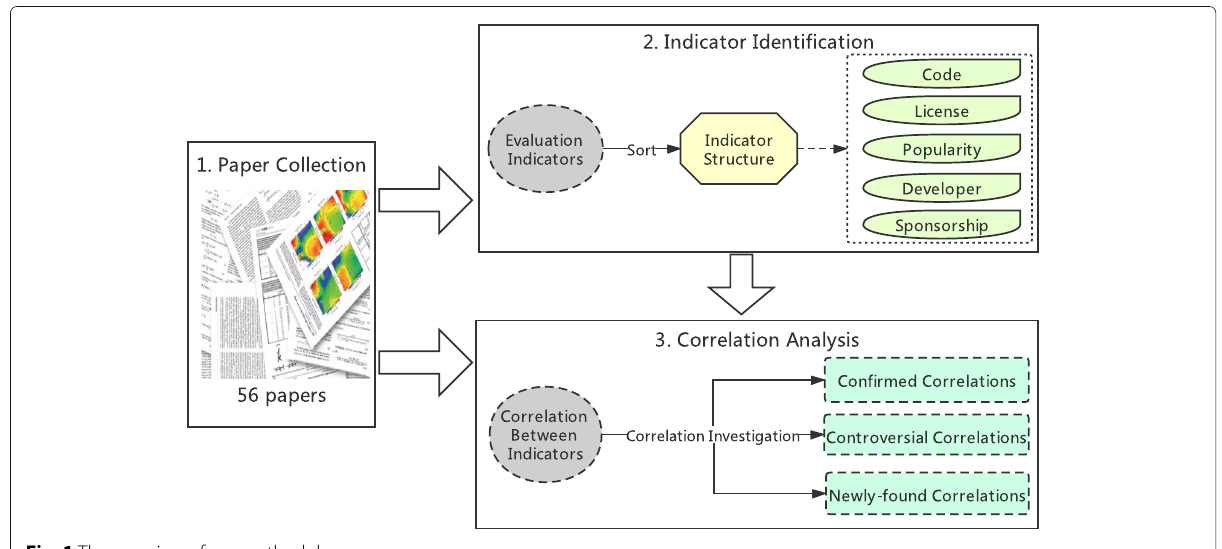
Fig. 1 The overview of our methodology